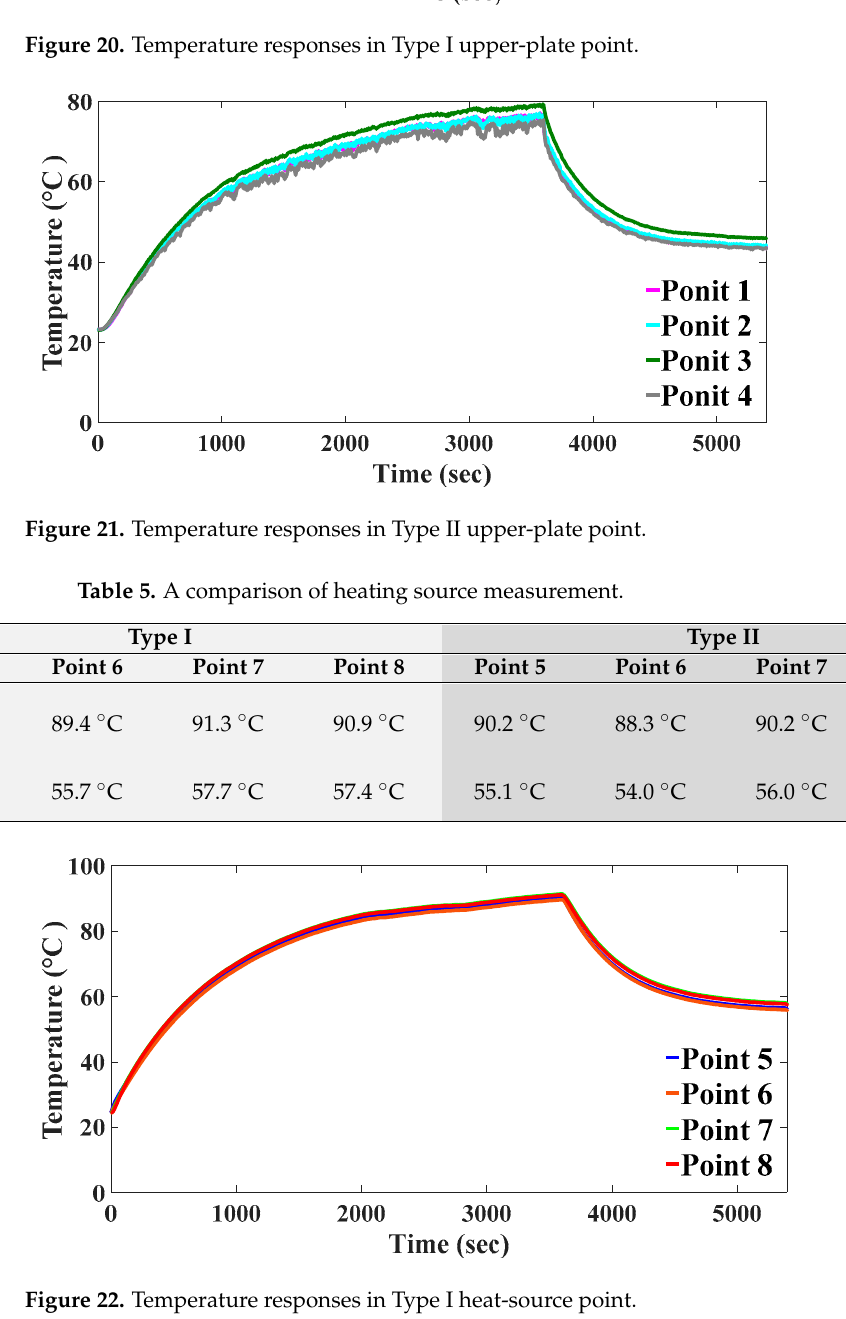
Figure 23. Temperature responses in Type II heat-source point. Figure 24. Temperature responses in Type I upper-plate point. Figure 25. Temperature responses in Type II Upper-plate point. 0